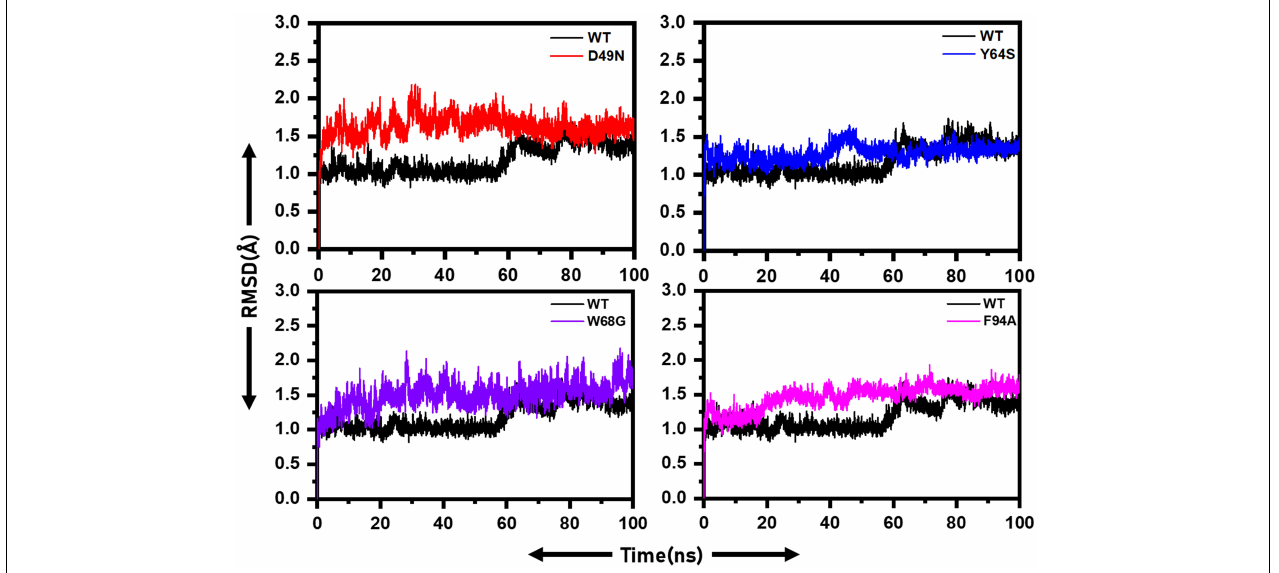
FIGURE 2 | RMSD of wild and mutants’ complexes. RMSD of each mutant is superimposed on to the RMSD of the wild type. The X-axis shows the simulation time in nanoseconds, while the y-axis shows the RMSD in Angstrom.